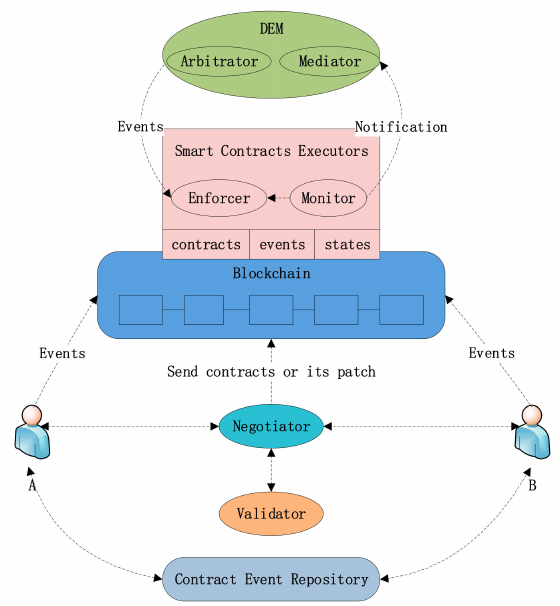
Figure 1. The role-based architecture of blockchain-based smart contracts